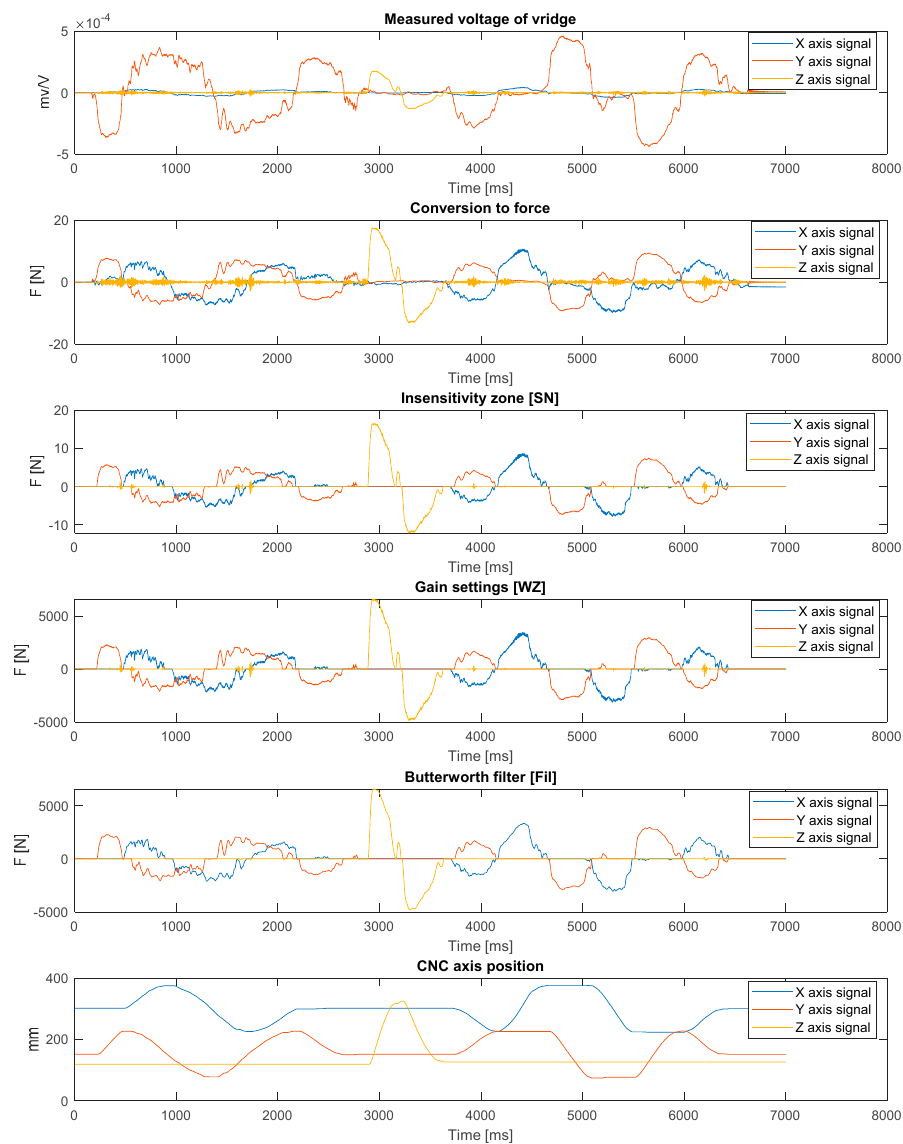
Figure 6. Signals at different stages of the processing algorithm (SN = 2N, WZ = 400, Fil: 4 Hz). First, the force with which the operator interacts with the lever is calculated as a function of the measured voltage and previous calibration. Another process consists in using a zone of insensitivity to eliminate components of measurement signals with values oscillating around zero, resulting in a continuous pre-setting of movement sense target variables (moments on the motor). The application of this procedure makes it easier to move the table along one axis of the table’s cruciform system, because when moving along one selected axis there are always low signal components from the perpendicular axis, which are cut out by the insensitivity zone. The advantage of this solution is easier operation without the need to switch to single-axis mode. One drawback is the possibility to have a worse representation of circular movements predetermined by the operator. In fact, the operator is not able to perfectly reproduce the circular movement, so one of the basic assumptions of the system is to resign from the possibility of saving the entire track of the movement of the upper limb in favor of saving individual selected and specified